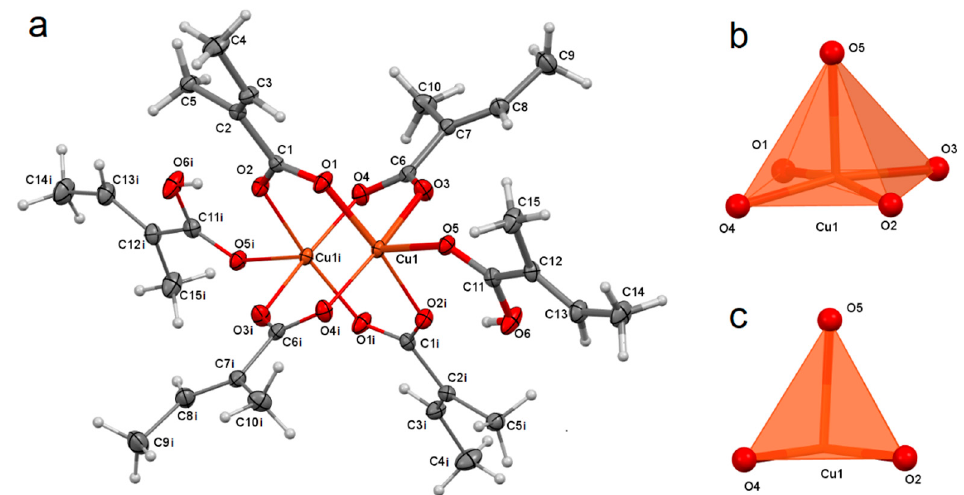
Figure 2. Molecular structure of [Cu 2 (tig) 4 (tigH) 2 ], with atom numbering scheme, plotted with 50% probability of displacement ellipsoids of nonhydrogen atoms. Hydrogen atoms are plotted as spheres of arbitrary radii. The symmetry generated atoms are indicated by i letter [symmetry code: − x + 1, − y + 1, − z + 1] ( a ). Coordination polyhedron of [Cu 2 (tig) 4 (tigH) 2 ], general view ( b ), view along tetragonal base ( c ).